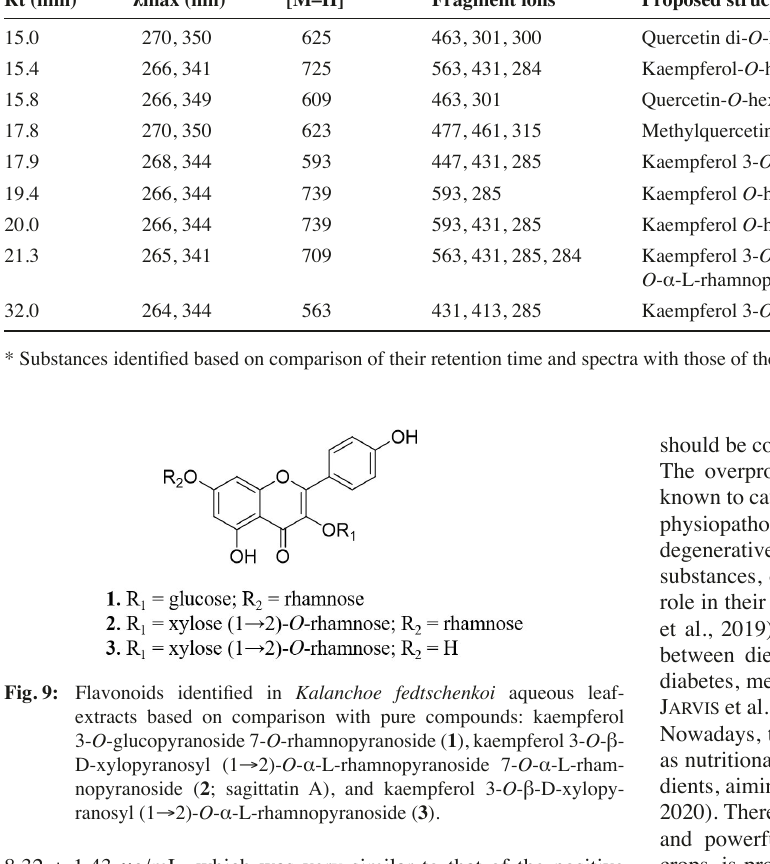
Tab. 1: Chromatographic and spectrometric properties of flavonoids detected in Kalanchoe fedtschenkoi aqueous leaf-extract by HPLC-DAD-ESI-MS/MS in the negative ion mode. Rt (min) λmax (nm)